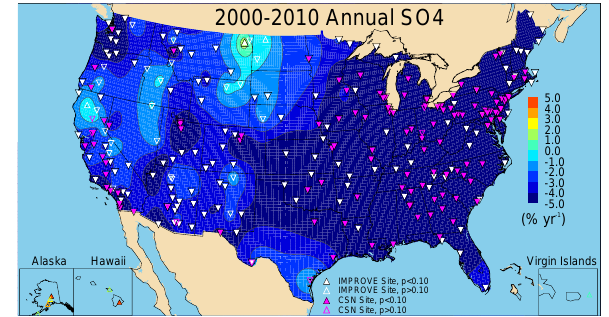
Fig. 3. IMPROVE and CSN 2000–2010 trends (% yr − 1 ) in annual mean particulate sulfate ion concentrations. White and magenta tri- angles correspond to IMPROVE and CSN sites, respectively; up- ward pointing triangles correspond to increased concentrations and vice versa. Trends with significance levels ( p ) less than 0.10 are considered